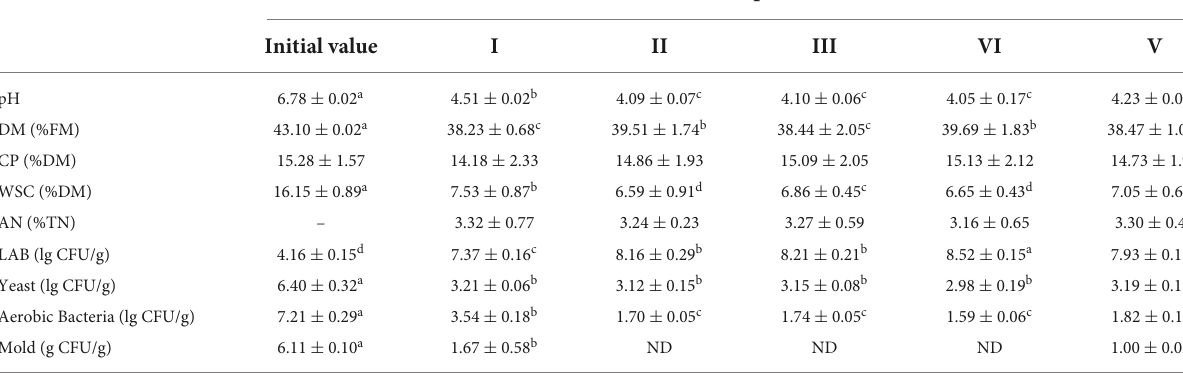
TABLE 3 Nutrient and fermentation quality of total mixed ration (TMR) after 60 days of